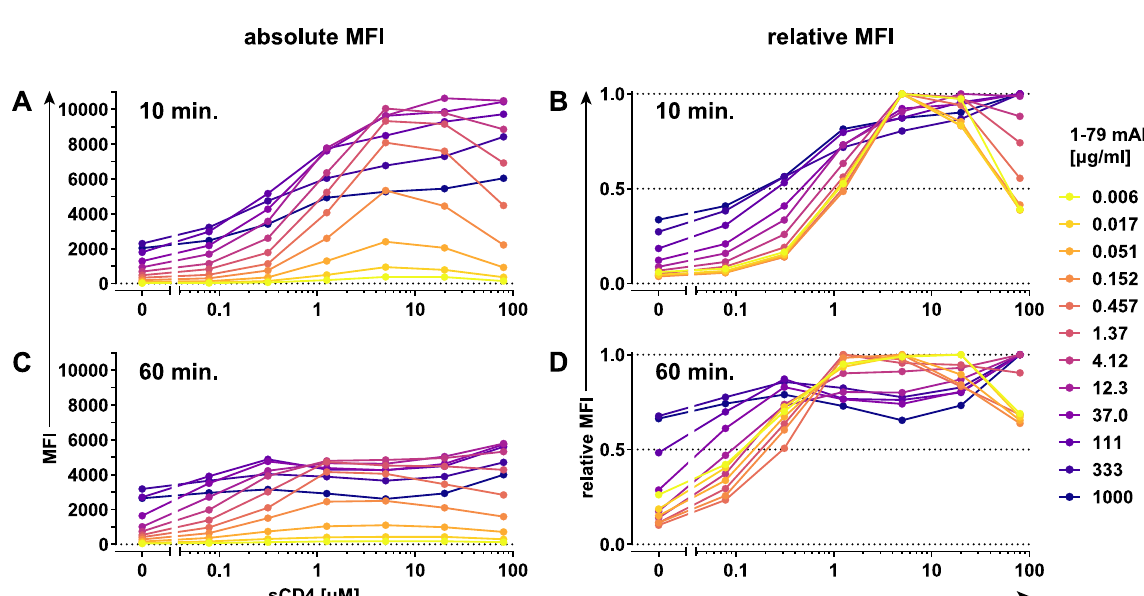
Fig 1. Triggering conformational changes in cell surface–expressed BaL.01 Env by sCD4. HEK 293T cells expressing BaL.01 Env were stained with indicated concentrations of V3 crown-directed mAb 1–79 in the presence of increasing concentrations of two-domain sCD4 for 10 minutes (A, B) or 60 minutes (C, D). The amount of antibody bound to the cell surface was quantified by flow cytometry. Dead cells were excluded from analysis, and background signal from MuLV Env–expressing control cells was subtracted. MFI staining curves (A, C) or MFI staining curves normalized to their maxima (relative MFI staining curves) (B, D) are plotted for every antibody concentration. Histogram plots of the event distributions underlying the above MFI values are depicted in S1 Fig. Data represent a single experiment. Env, envelope glycoprotein; HEK, human embryonic kidney; mAb, monoclonal antibody; MFI, mean of fluorescence intensity; MuLV, murine leukemia virus; sCD4, soluble CD4; V3, third hypervariable.